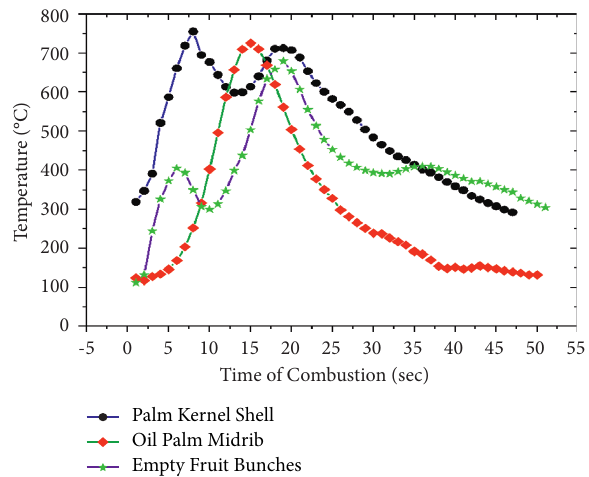
Figure 12: Profile temperature for different fuels at the measurement